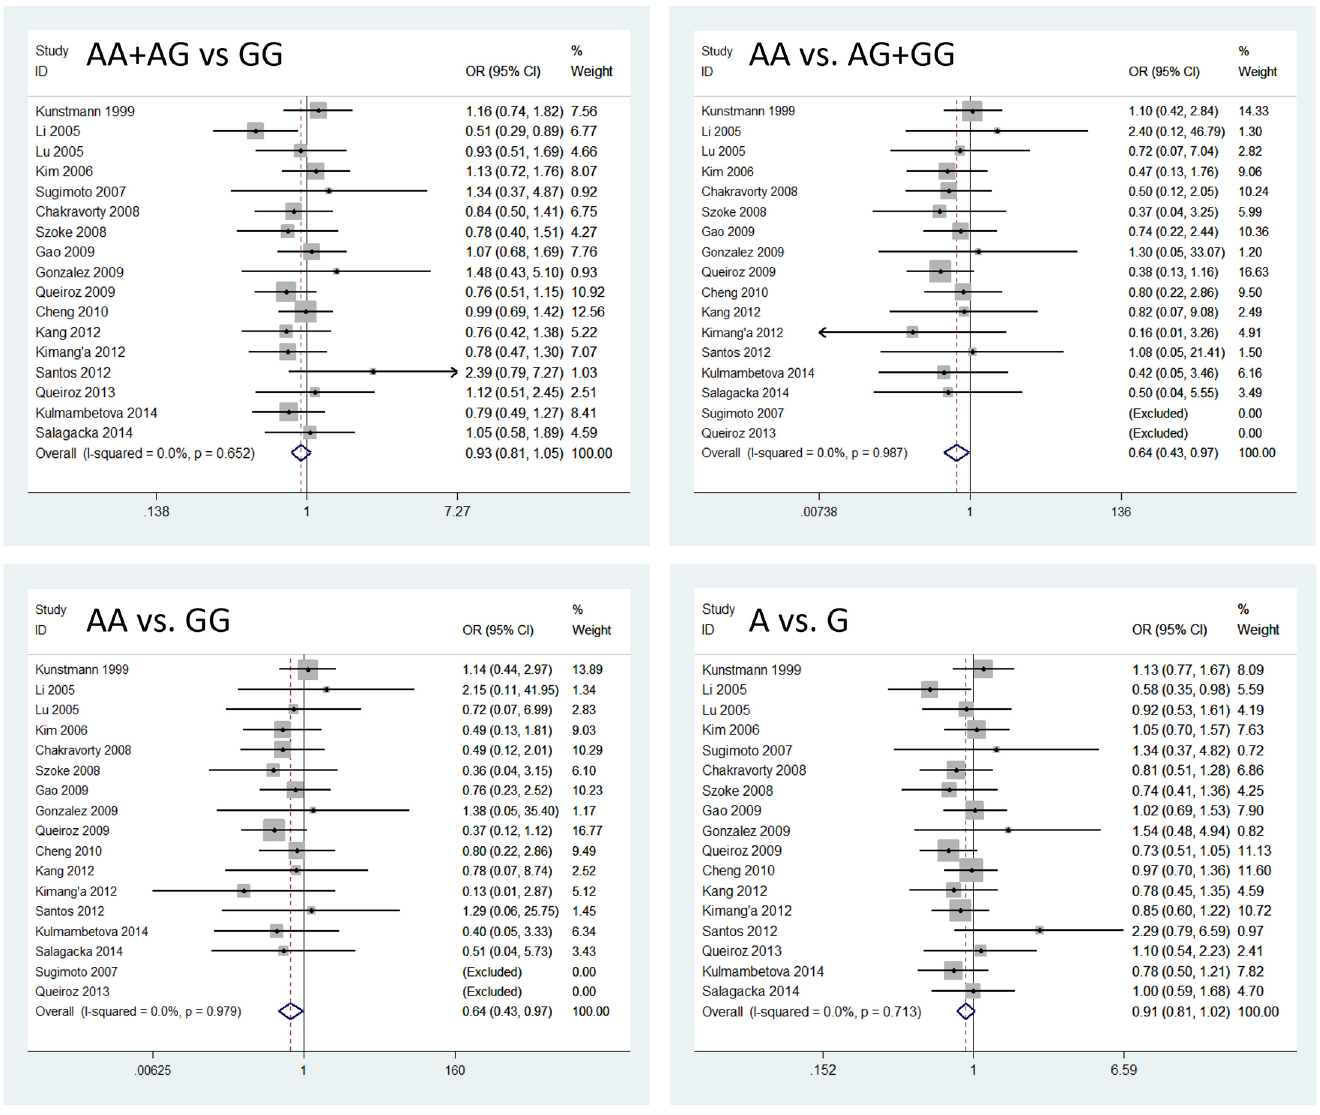
Fig 2. Forest plots for all models to show an association between the TNFA -308G > A polymorphism and H . pylori